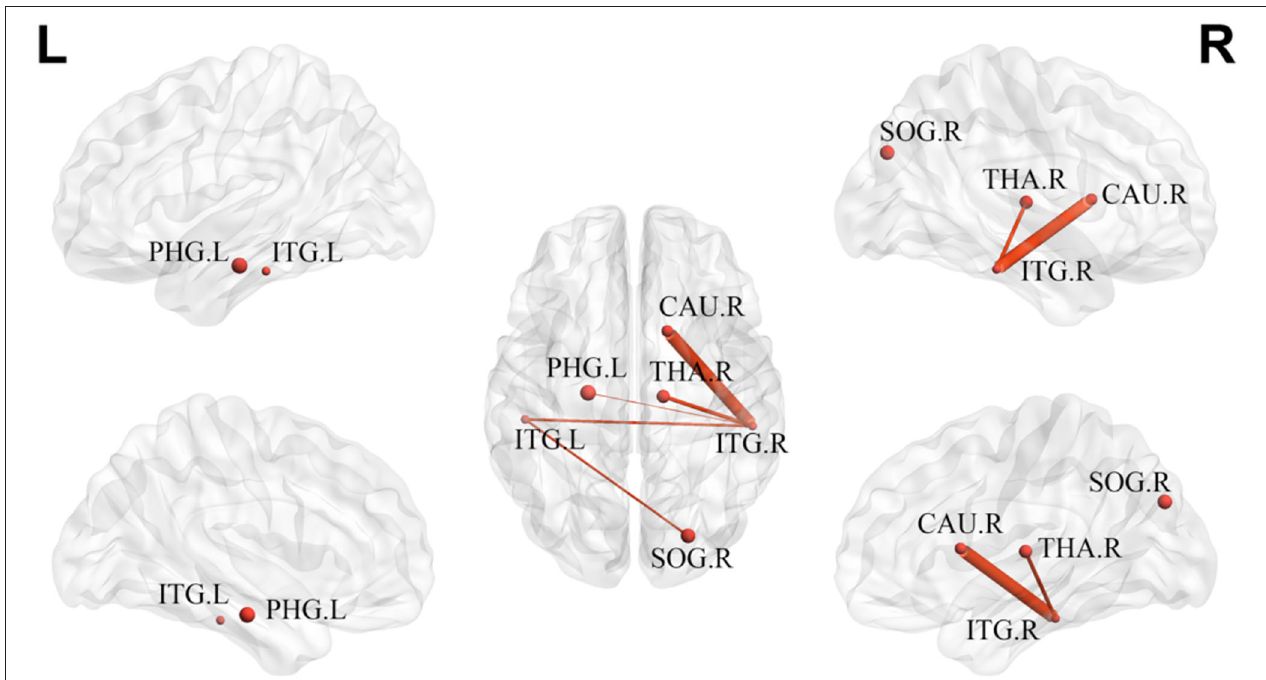
FIGURE 5 | The disrupted component in mTBI group at acute stage. ITG, inferior temporal gyrus; PHG, parahippocampal gyrus; CAU, caudate nucleus; THA, thalamus; SOG, superior occipital gyrus; L, left; R,